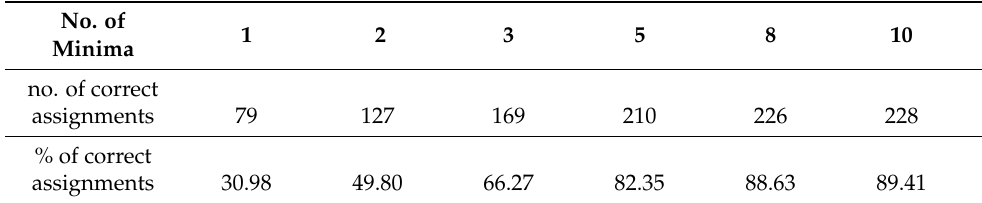
Table 1. CASME II dataset. Number of correspondences between minima of the temporal quantity σ F ( t ) and frozen frames’ nearby MEs. The correspondences were searched for among the first K local minima of σ F having the smallest values. The percentage of correct assignments with respect to the total number of analyzed video is also